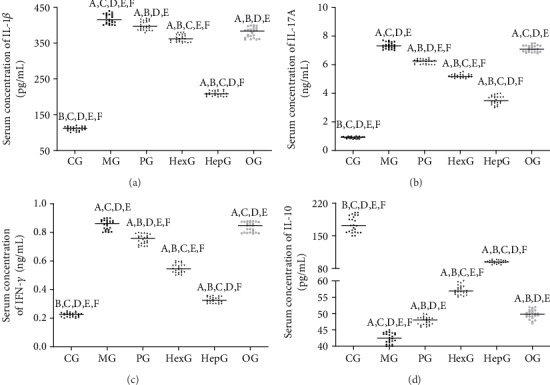
ELISA analysis of serum inflammatory factors. (a) Interleukin- (IL-) 1β. (b) IL-17A. (c) Interferon- (IFN-) γ. (d) IL-10. Ap < 0.05 vs. the CG group, Bp < 0.05 vs. the MG group, Cp < 0.05 vs. the PG group, Dp < 0.05 vs. the HexG group, Ep < 0.05 vs. the HepG group, and Fp < 0.05 vs. the OG group. n = 8 for each group.